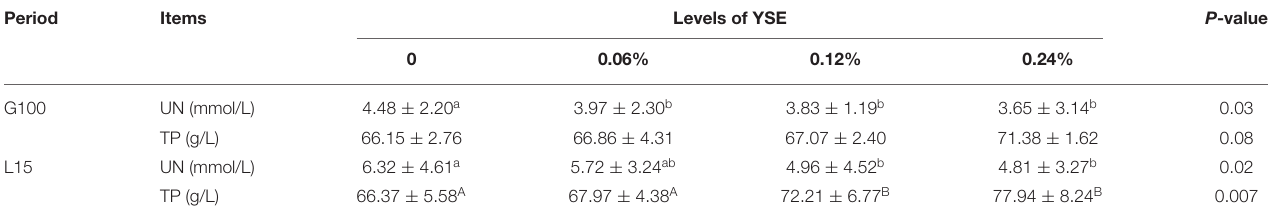
TABLE 5 | The content of UN and TP in serum of sows with different levels of YSE supplementation. Period